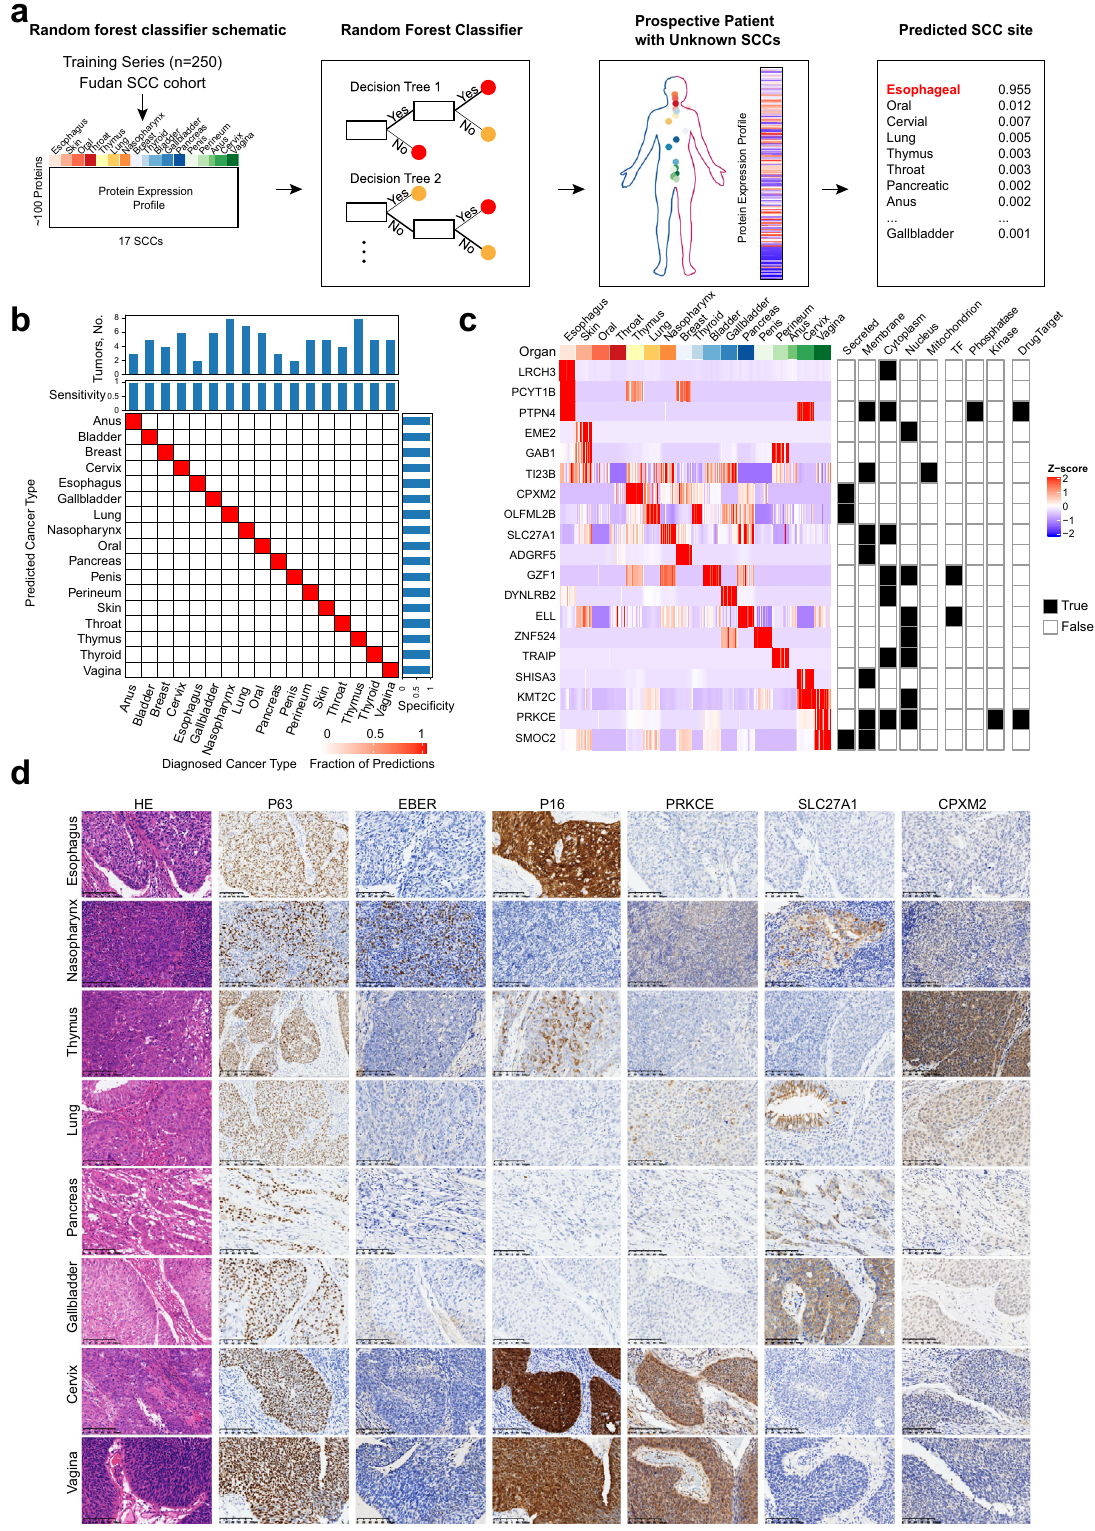
found CPXM2 IHC staining, in agreement with the proteomics data, was highly expressed in thymus SCCs (Spearman correla- tion, p = 0.015; Fig. 7d and Supplementary Fig. 11d, e). These results highlight the power of incorporating proteomics and pathology to explore cancer-type-speci fi c